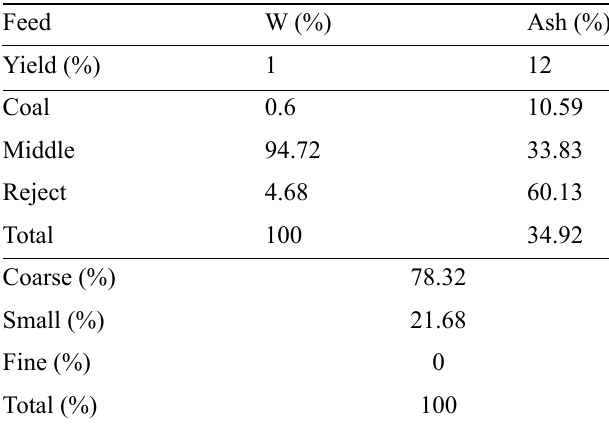
Table 2. Washability test results of the middle load of the tri-flo separation in TCPP.